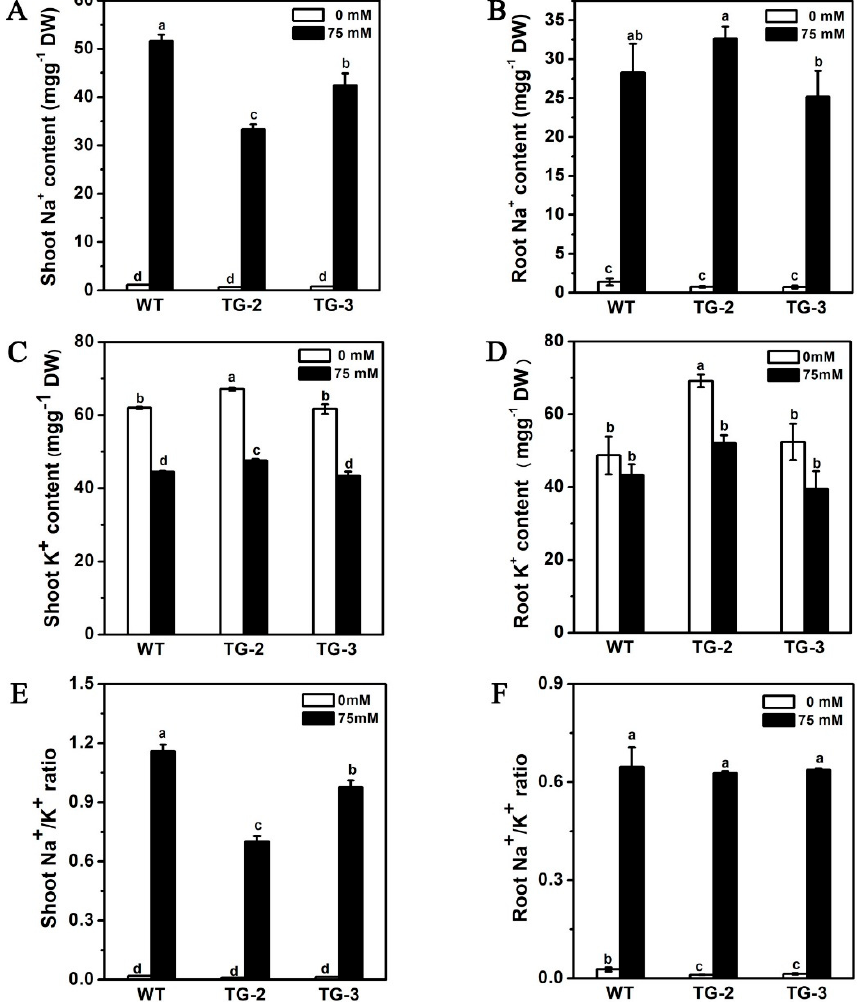
Figure 7. Shoot and root Na + /K + content in control and NaCl-treated transgene CmHKT1;1 cucumber. Transgene CmHKT1;1 cucumber cultivated in hydroponics with 75 mM NaCl for 7 days. Shoot Na + content ( A ), K + content ( C ) , and Na + /K + ratio ( E ). Root Na + content ( B ), K + content ( D ), and Na + /K + ratio ( F ). WT, wild type. TG, transgene CmHKT1;1 . Each value is the mean of three replications ± standard error of the means. Columns with different letters indicate they are significantly different at the p < 0.05 level (Duncan test).